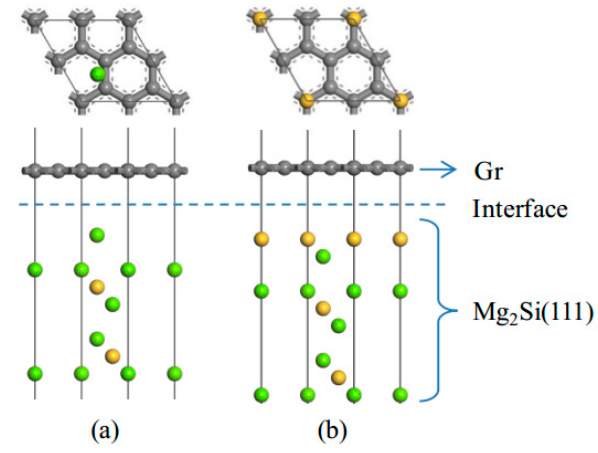
Figure 9. Interfacial atom stacking site and interfacial model of Mg 2 Si (111)/Gr (0001) interface: ( a ) Mg-termination; ( b ) Si-termination (the green ball represents Mg atom, the yellow ball represents Si atom, the gray ball represents C atom).